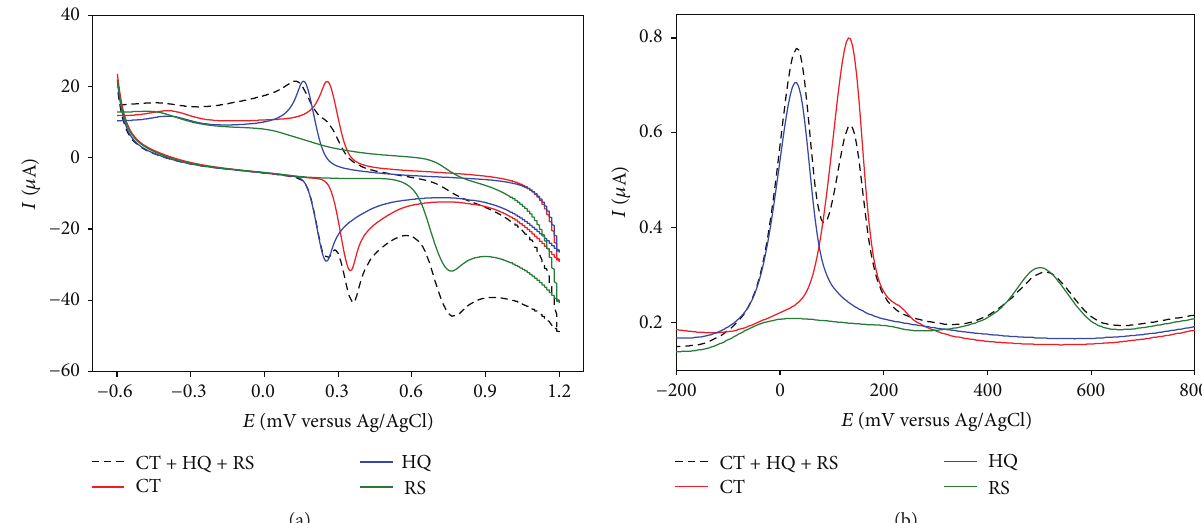
Figure 6: (a) CVs of individual (solid lines) and ternary mixture (dashed line) of CT, HQ, and RS; (b) DPV responses of individual (solid lines) and ternary mixture (dashed line) of CT, HQ, and RS in ABS at PGA modified GCE.